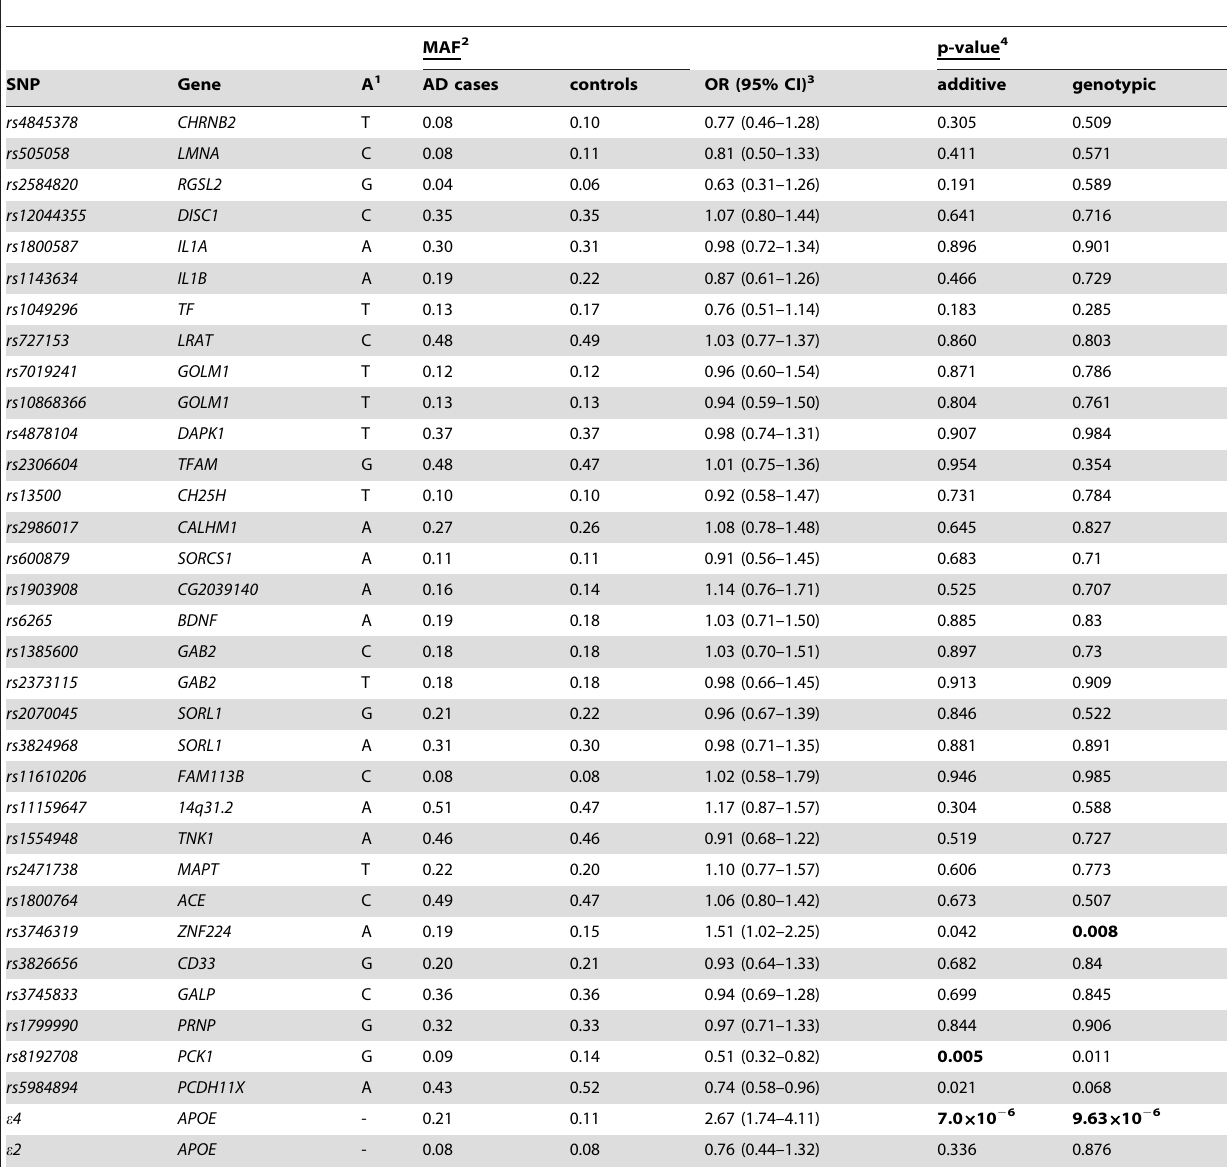
Table 3. Relation of candidate AD polymorphisms to clinical AD